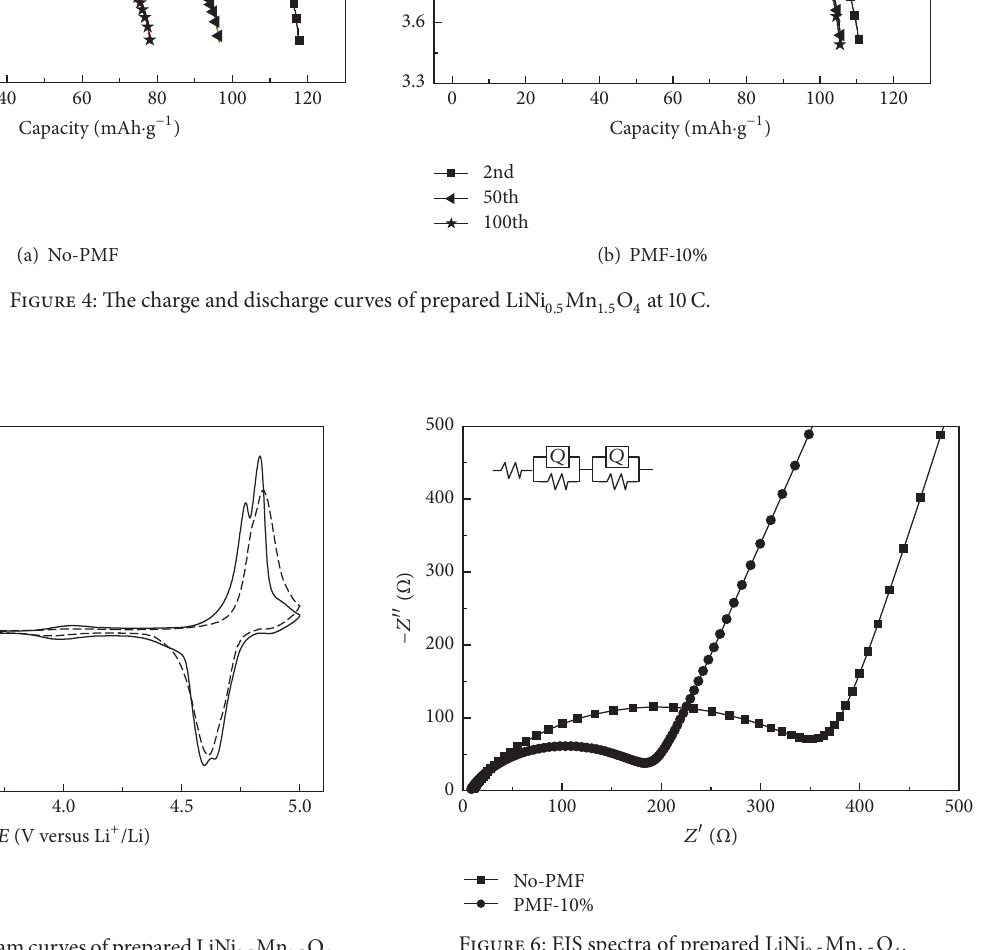
LiNi 0.5 Mn 1.5 O 4 . The as-prepared LiNi 0.5 Mn 1.5 O 4 has the